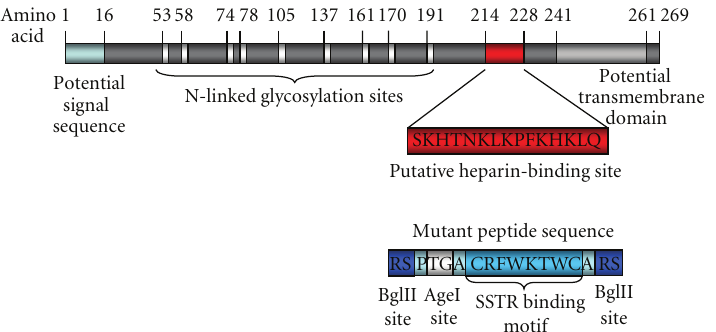
Figure 1: Substitution of the heparan sulphate-binding region of HVS ORF51 protein. Analysis of the peptide sequence of the 269 amino acid protein indicates that there is an N-terminal signal sequence, 9 N-linked glycosylation sites, a potential heparan sulphate-binding site and a transmembrane domain. In the mutant ORF51 virus the heparan sulphate-binding site, highlighted in red, is replaced with the peptide sequence in blue. This sequence contains the SSTR binding motif.